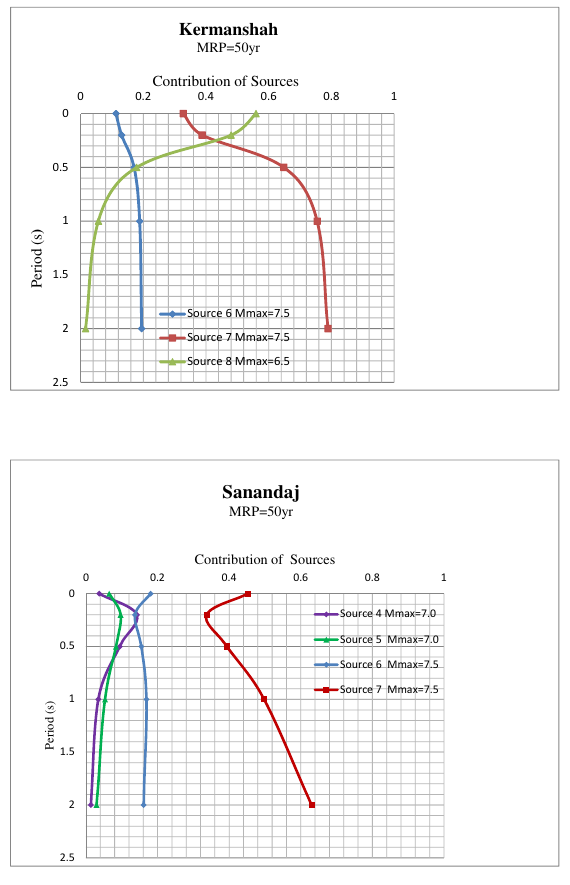
Figure 9. The most contributing seismic sources corresponding to 50-year return period in Kermanshah and